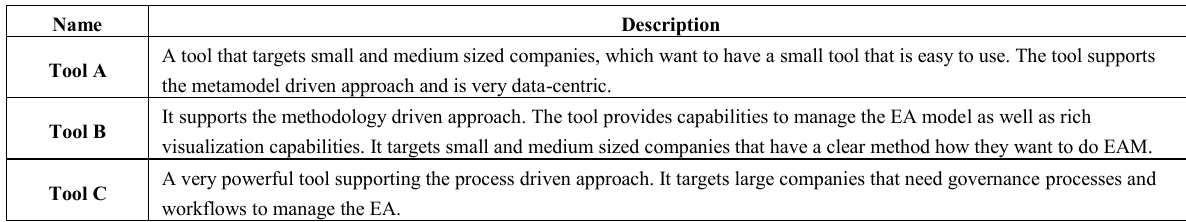
Table 1. Description of EAM tools, which we